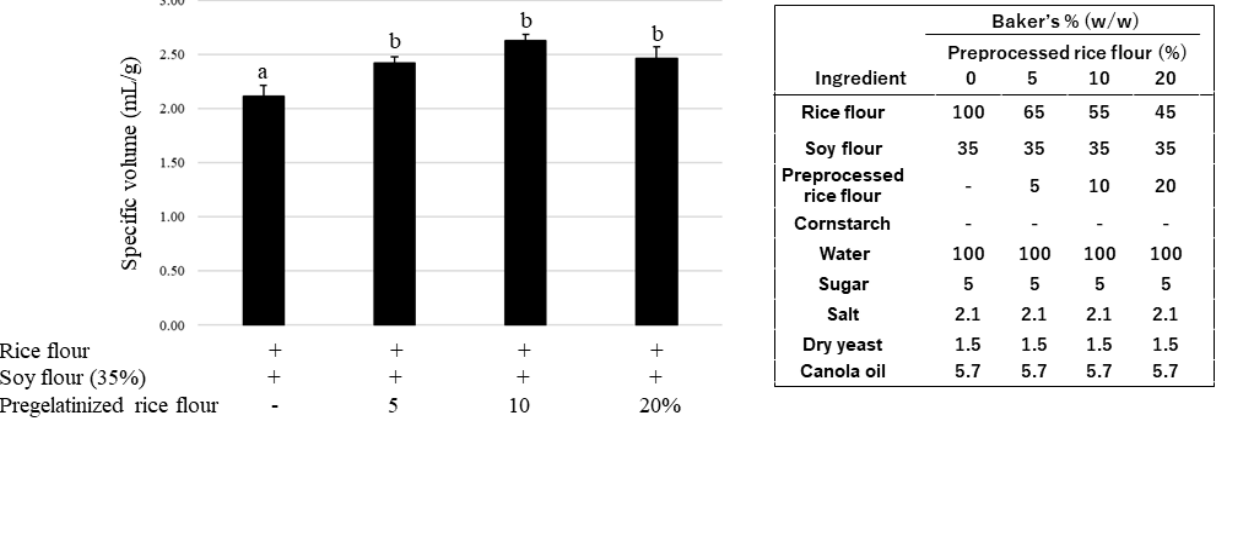
Figure 2. ( A ) Effect of soy flour substitution amount on the specific volume of bread; ( B ) Recipes for soy rice bread with preprocessed rice flour. Data are shown as mean ± SD. Different letters indicate p < 0.05 between groups.